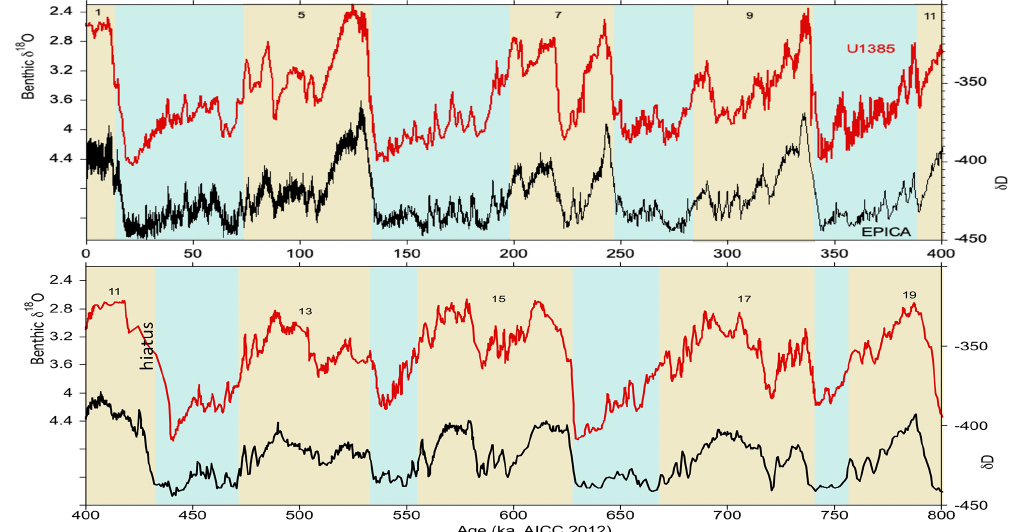
Figure 13. Comparison of benthic δ 18 O from MD01-2444 and Site U1385 on the Iberian margin (red, this study) and δ D from EPICA Dome C ice core, Antarctica, for the last 800kyr (black, Jouzel et al., 2007). Timescale is AICC2012 (Veres et al., 2013). Interglacial marine isotope stages are numbered and shaded